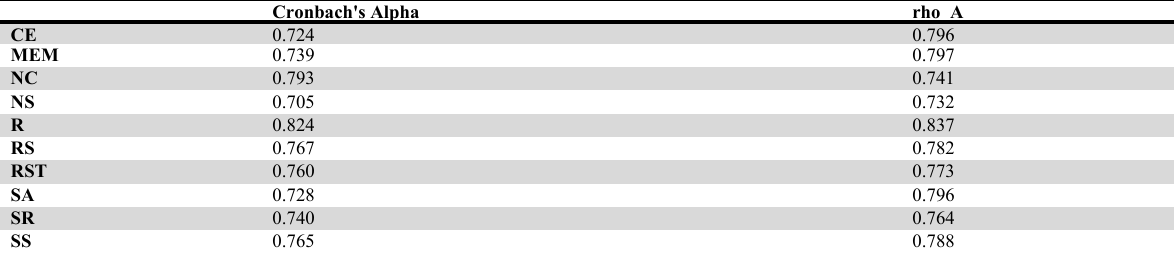
Convergence validity and reliability indexes